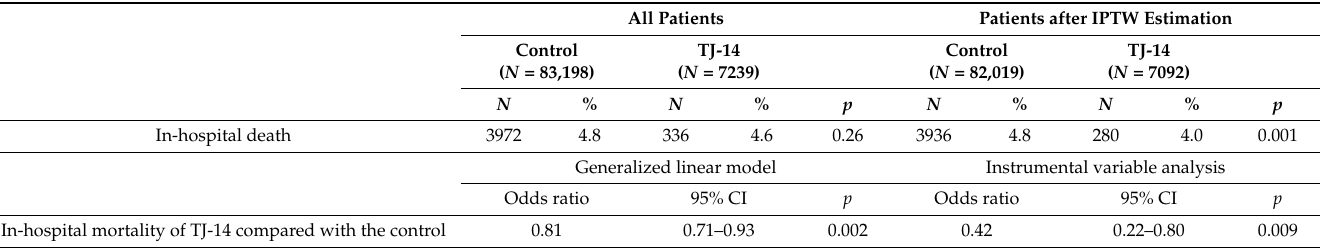
Table 4. In-hospital death on first admission for CPT-11 administration with or without